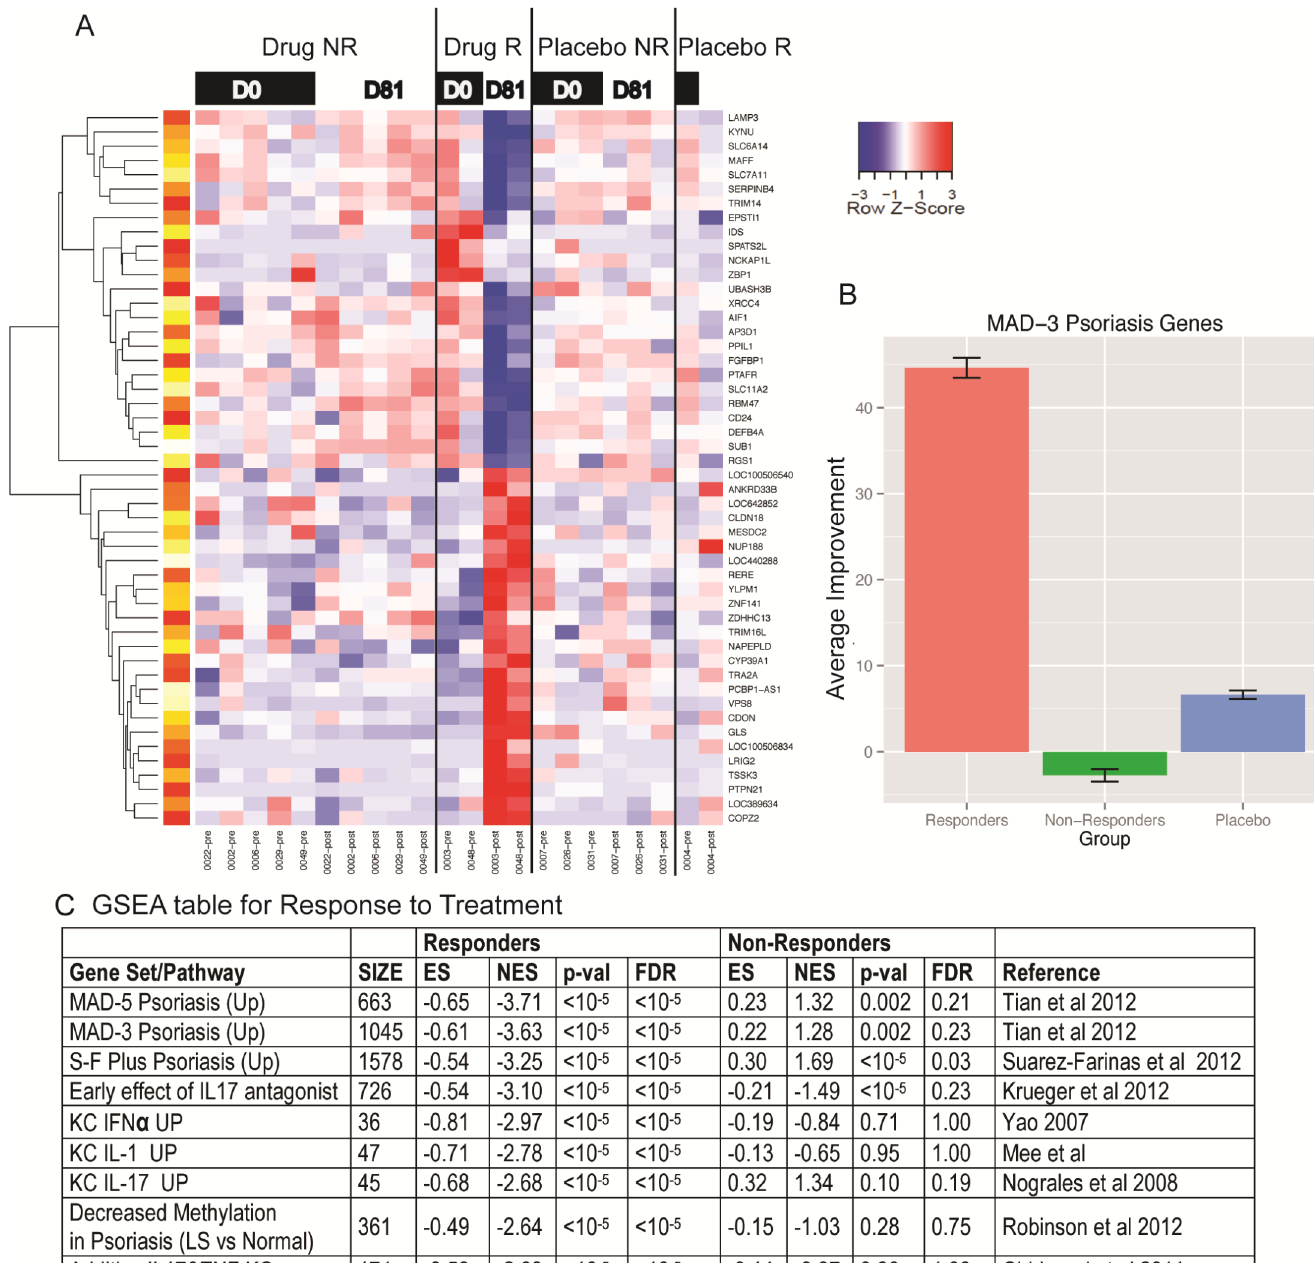
Fig 4. Microarray analysis in skin biopsies (A) Heat-map of genes modulated by drug treatment in psoriasis subjects (B) Average improvement after treatment for placebo, responders and non-responders (C) Gene set enrichment analysis for psoriasis transcriptome (Tian, Yao, Suarez-Farinas, Chircozzi, and Nograles) with respect to the IL-17/TNF- α synergistic phenotype, as defined by the synergistic increase.